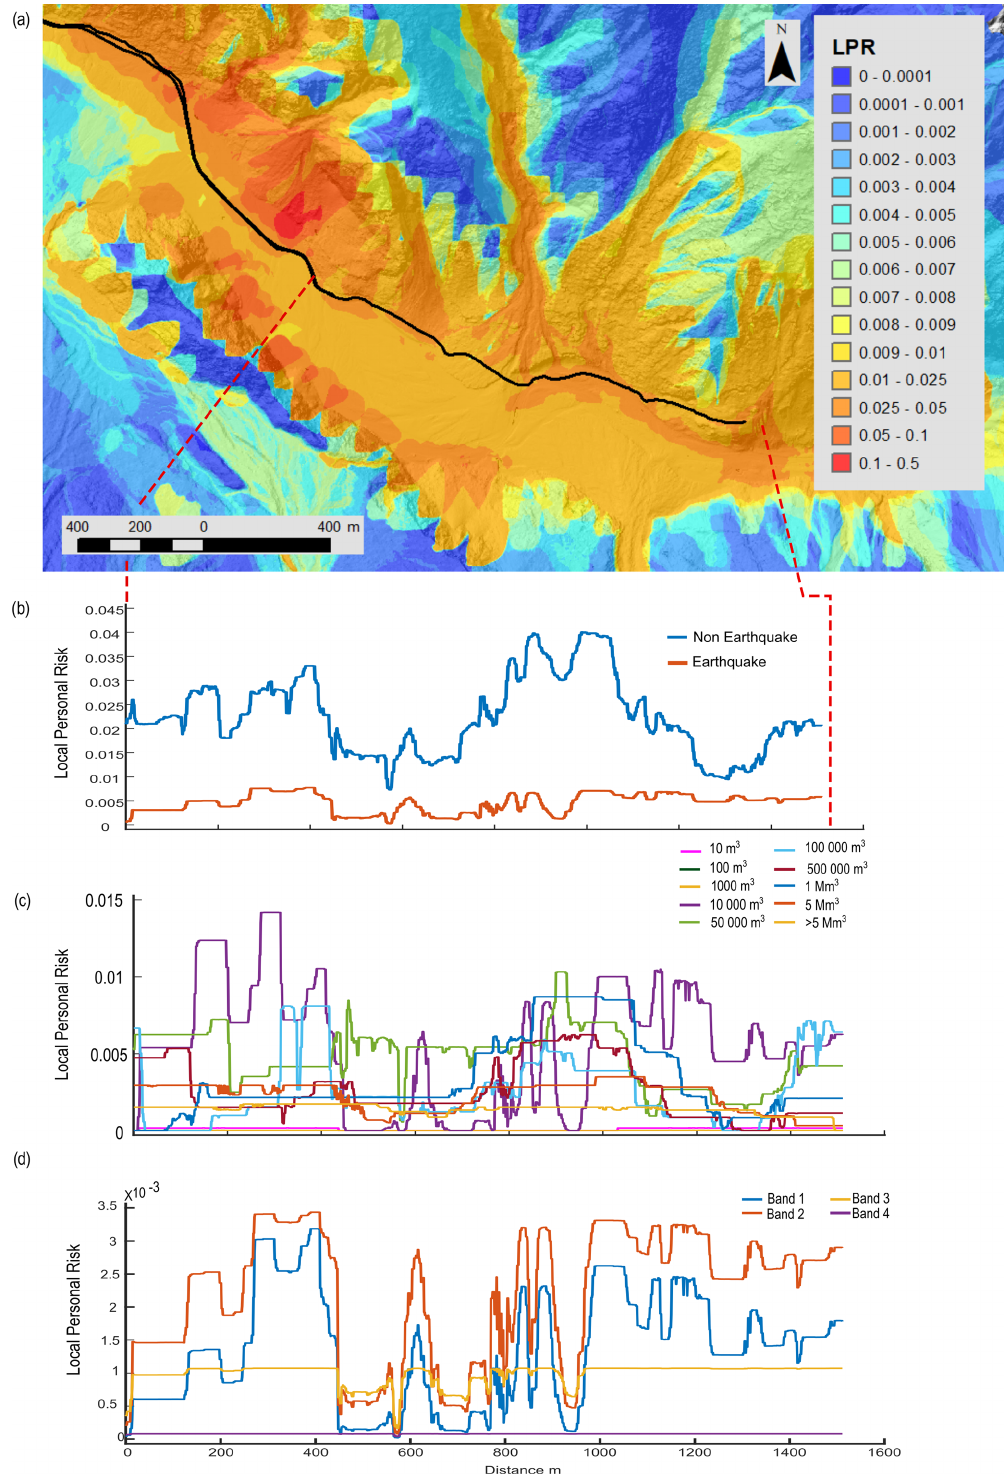
Figure 8. Risk results from Scenario 1 (central estimate) risk model for the Fox Glacier valley. (a) LPR map displaying areas of higher and lower risk, along with the location of the access track (black line) in the valley. The risk results presented in (b) to (d) are extracted along the track in (a) . (b) LPR values for aseismic landslides compared with seismic landslides. (c) LPR values for different volume classes of aseismic landslides. (d) LPR values for the different bands of ground shaking (from the lowest, Band 1, through to the highest, Band 4).